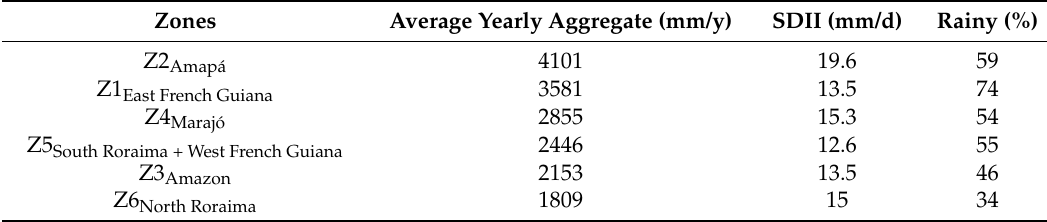
Table 1. The average annual total simple day intensity index (SDII) (mm/year) accounting for the daily average of rainy days and the percentage of rainy days. Areas are ranked in descending order of the average annual aggregate. Zones Average Yearly Aggregate (mm/y) SDII (mm/d) Rainy (%) Z2 Amapá